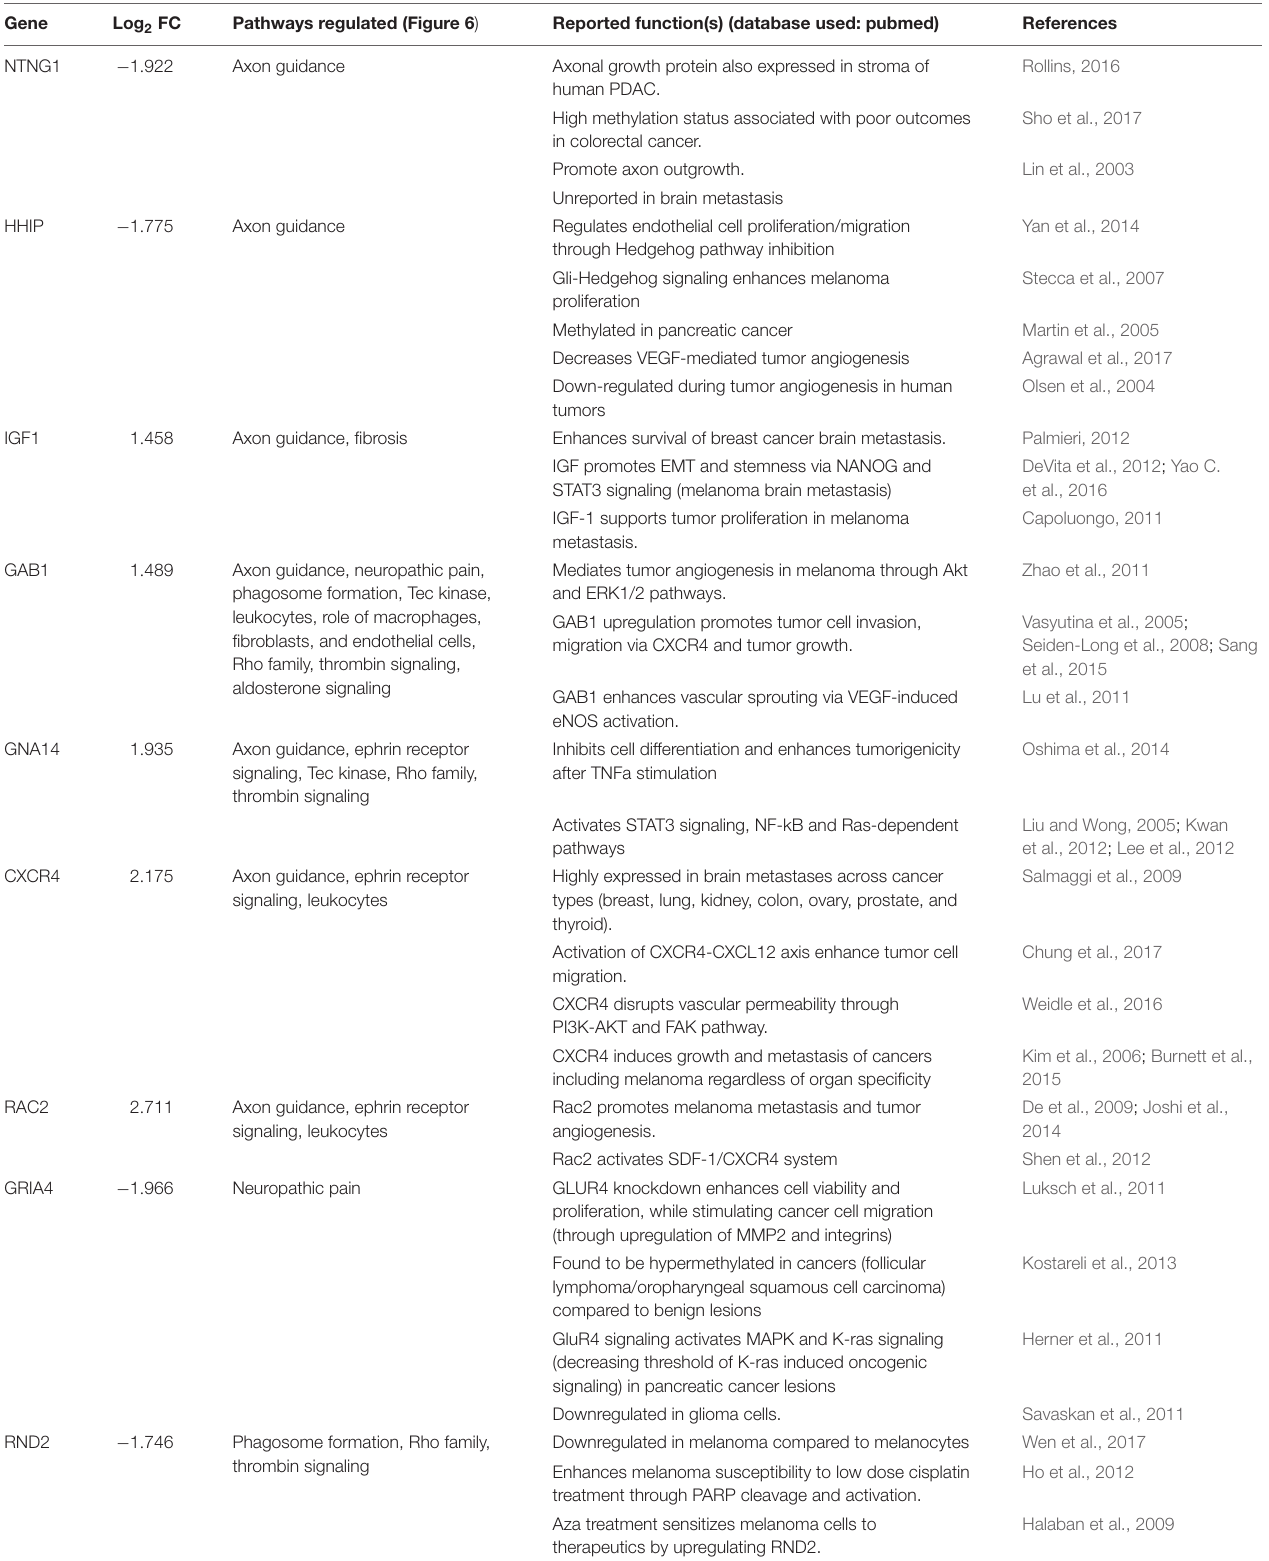
TABLE 1 | Functionally relevant gene identified from Stroke-MET transcriptome. Gene Log 2 FC Pathways regulated (Figure 6 ) Reported function(s) (database used: